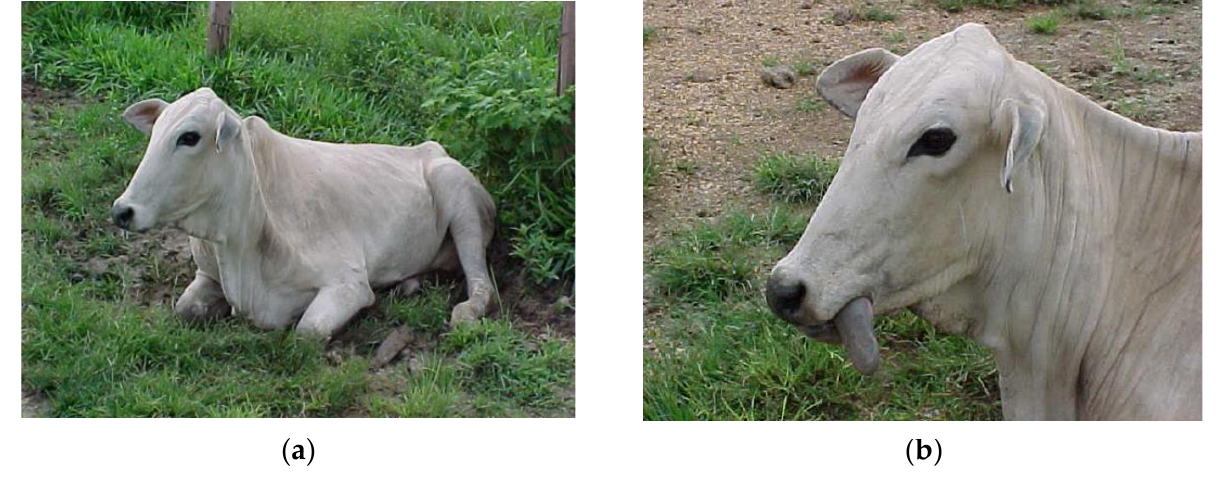
Figure 8. ( a ) Cow in the initial phase of botulism, in sternal decubitus and with sensorium in a state of alert. ( b ) A few days later, unable to retract the tongue when this organ is pulled out of the oral cavity (“the tongue test” is a common procedure among veterinarians to confirm a suspected case of botulism) (Photos courtesy of Prof. José D. Barbosa).